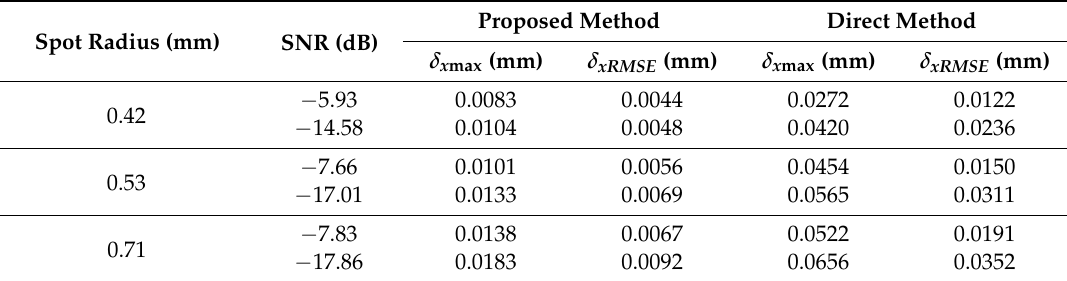
Table 2. The errors in different spot radius and SNR